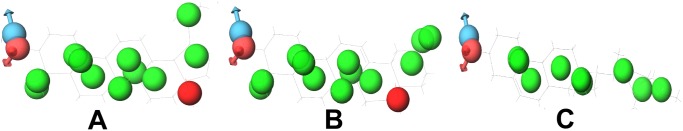
Compounds (with their pharmacophoric features) that target DNA polymerase beta.(A) Betulinic acid, (B) Oleanolic acid and (C) Stgmasterol. These compounds show similar pharmacophoric features.